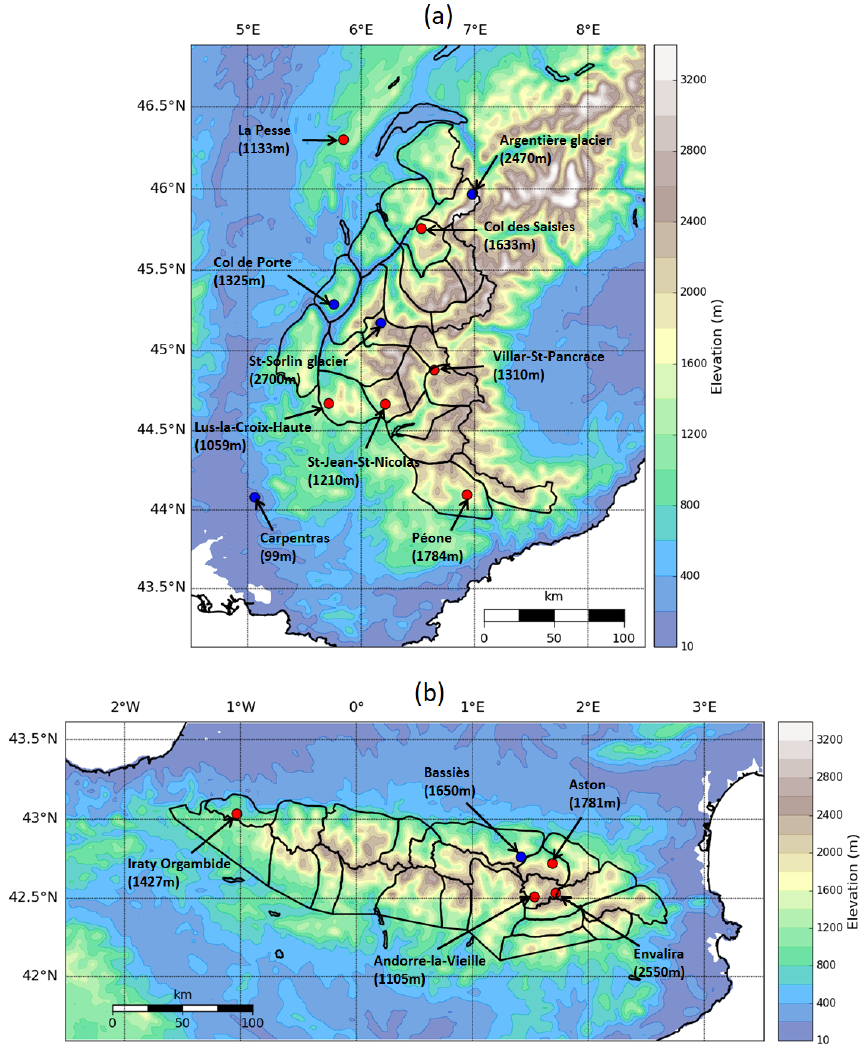
Figure 1. Domains of study: (a) the French Alps and (b) the Pyrenees, with AROME topography at 2.5km resolution. Red dots: SW ↓ stations; blue dots: SW ↓ and LW ↓ stations; black lines: SAFRAN